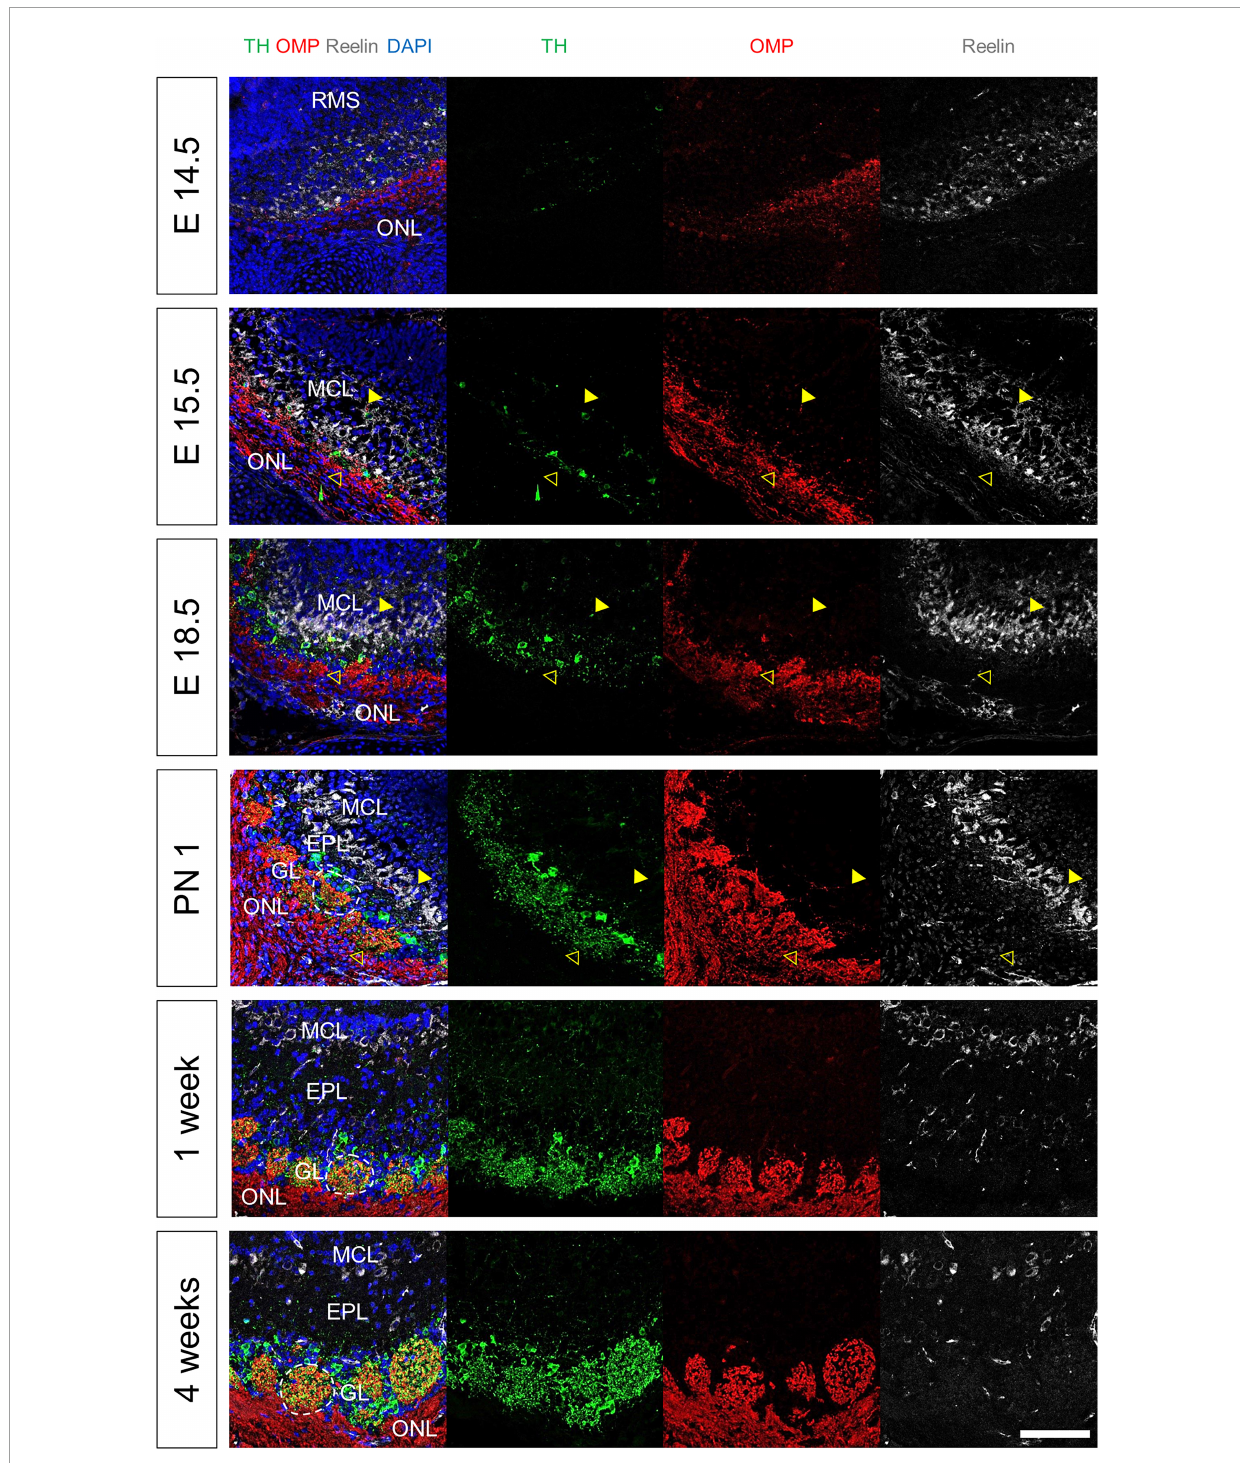
FIGURE5 Molecular and cellular changes during the development of OB layers. All images were obtained in the sagittal direction. Immunostaining with anti-TH, anti-OMP, and anti-Reelin antibodies, and DAPI at E14.5, E15.5, E18.5, PN 1, and 4 weeks. Yellow solid arrows, yellow hollow arrows, and white lines indicate the MCL, GL, and glomerulus, respectively. Scale bar, 100 µ